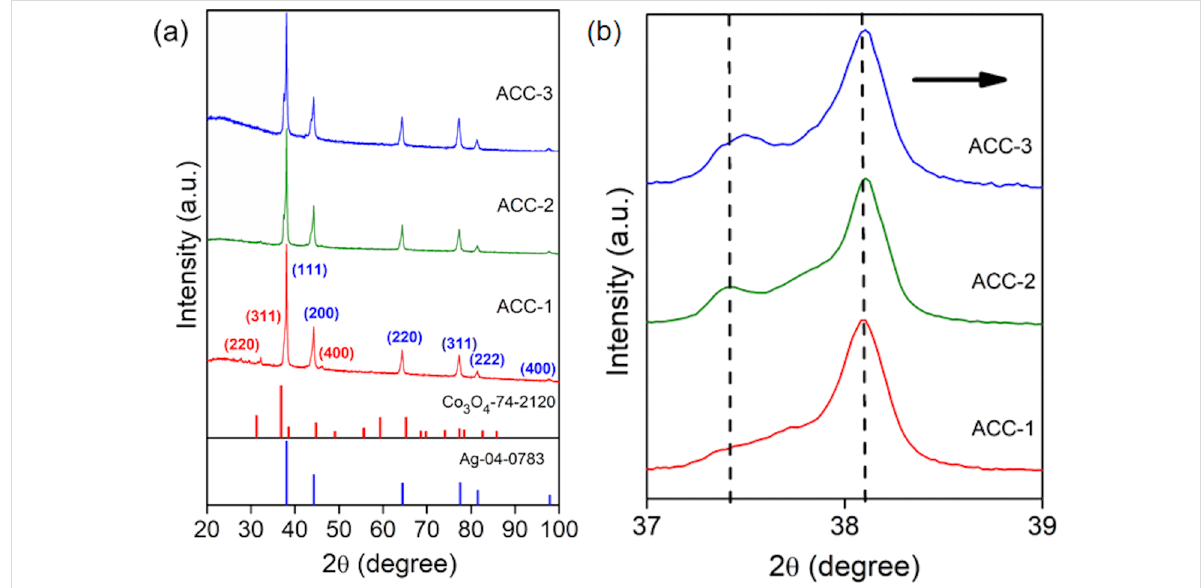
Figure 2: (a) PXRD patterns of ACC-1, ACC-2, and ACC-3. (b) Magnified area displaying angle shifts in the range of 2 θ = 37°–39°.